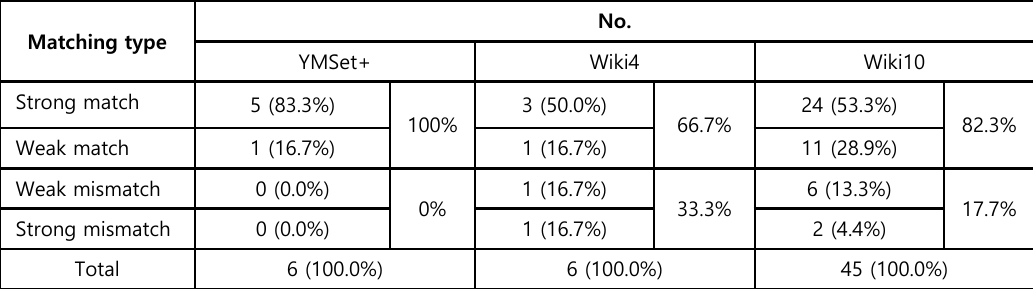
Figure 22. The matching results of confusion